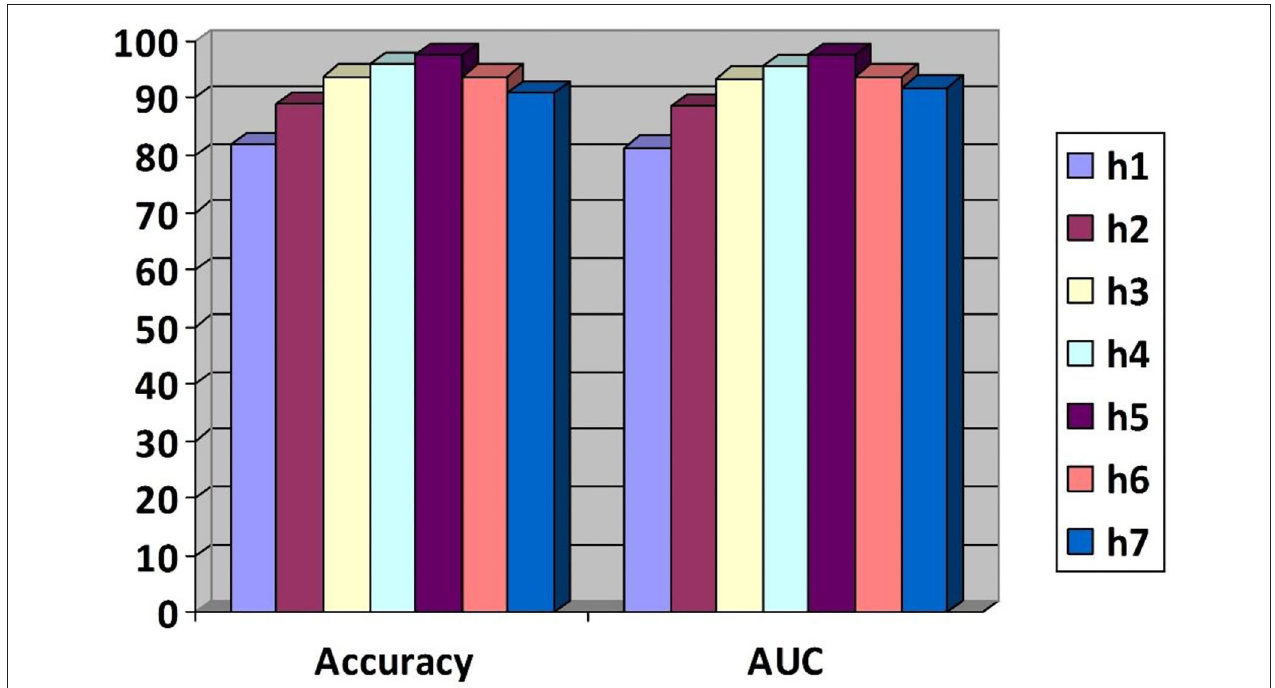
FIGURE 5 | The area under the curve (AUC) and accuracy values are based on a varying number of hidden layers.